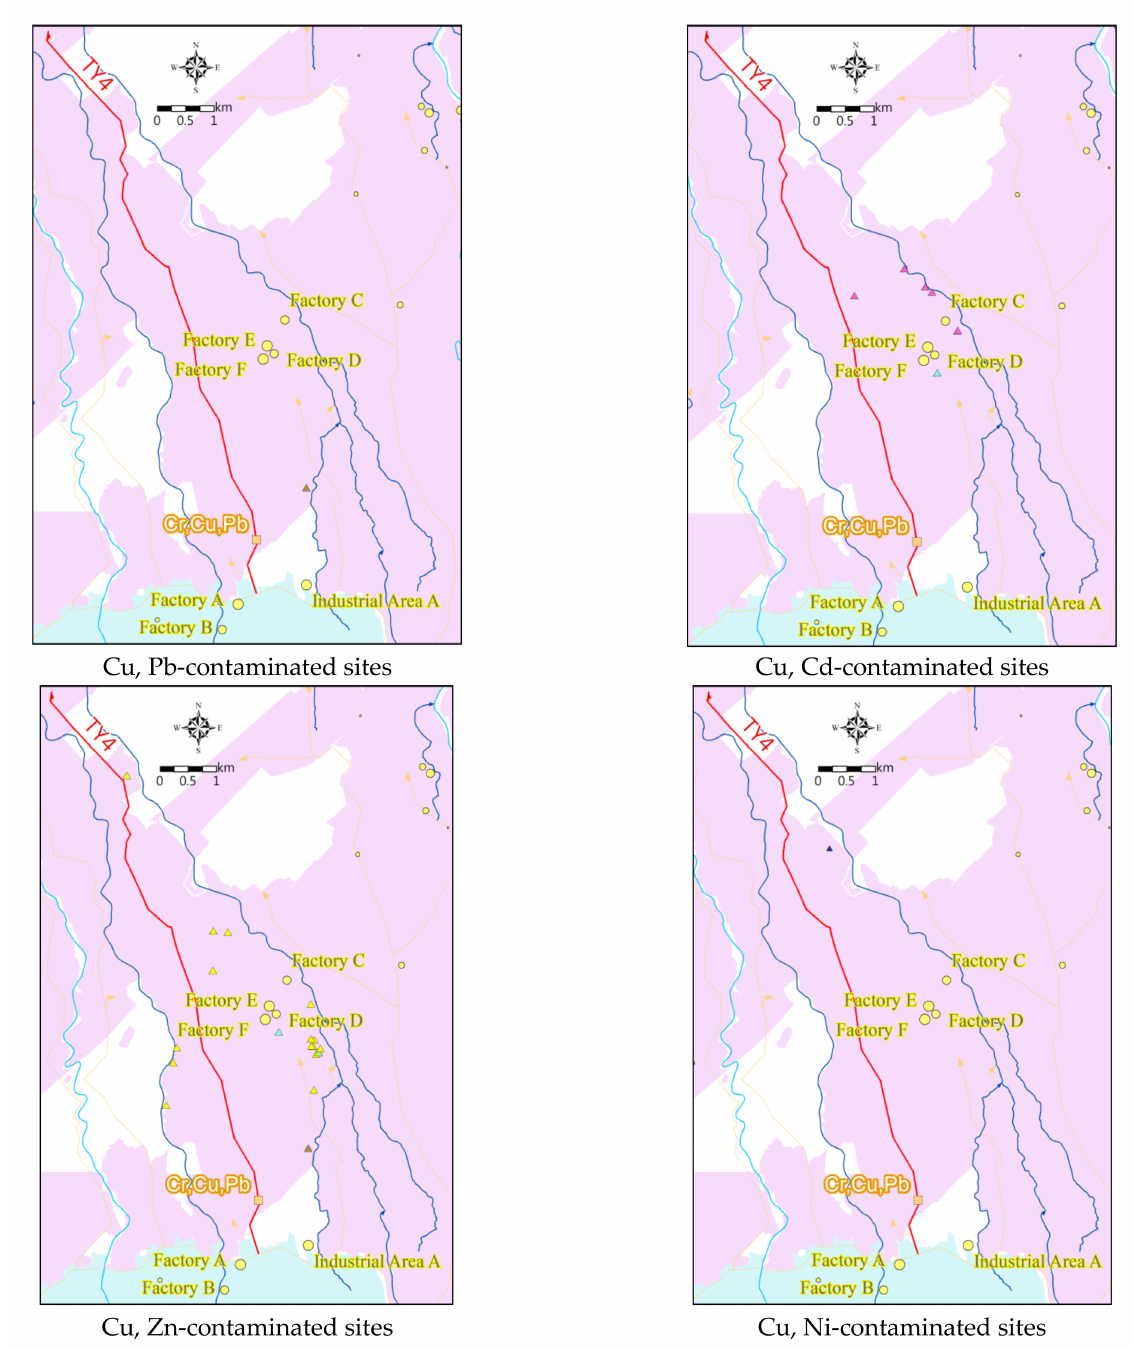
Figure 7. Sediment and agricultural land pollution sites in Taoyuan and the distribution of possible pollution